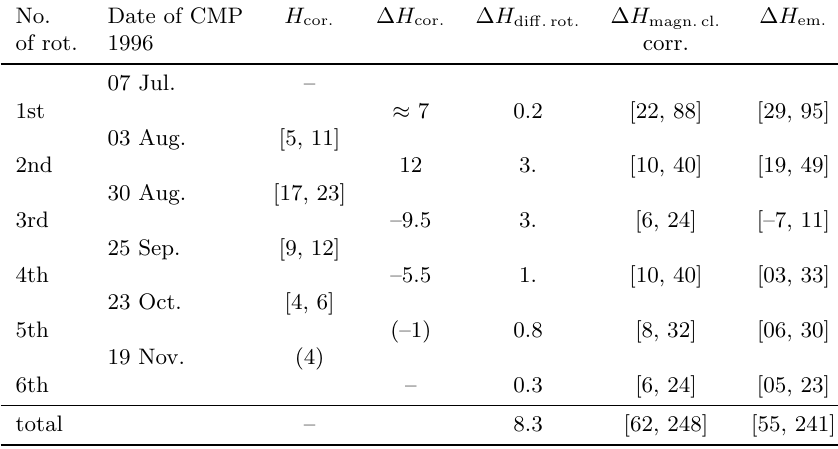
Table 7: The magnetic-helicity budget of AR 7978 is listed per rotation. An interval of helicity is given for the corona (3rd column) and for the cloud estimations with the observed number of CMEs (considering the two lengths (0.5 and 2 AU) of the twisted interplanetary flux tube. The budget is discussed in the text. All values are in units of 10 42 Mx 2 . Adapted from D´emoulin et al. (2002b). No. Date of CMP 𝐻 cor . Δ 𝐻 cor . Δ 𝐻 diff . rot . Δ 𝐻 magn . cl . Δ 𝐻 em